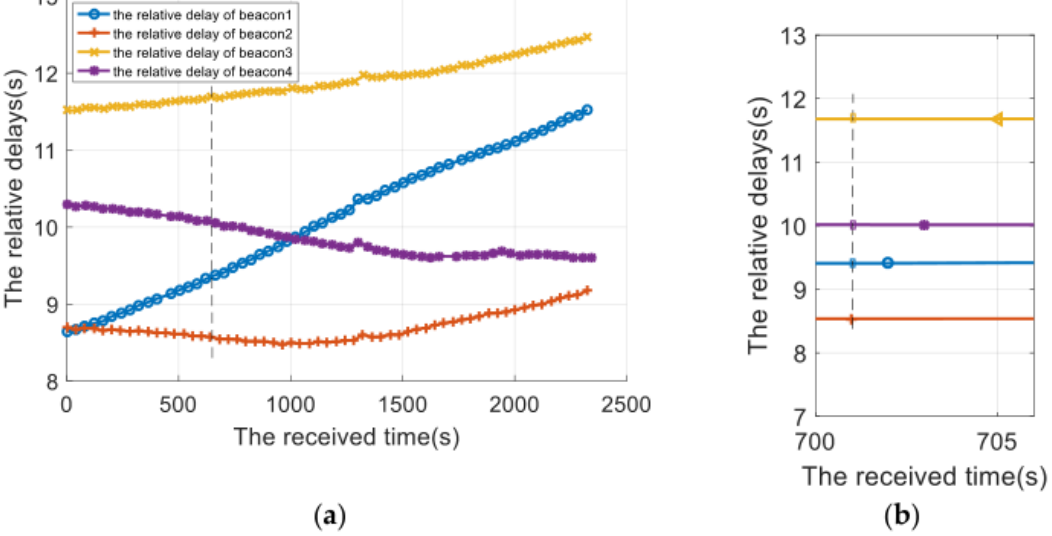
The result of the positioning signal after delay calibration is shown in Figure 16. The dotted line in the figure corresponds to the measurement delay of the 70th positioning cycle. The enlarged view in the lower right corner corresponds to the measurement delay after compensation.